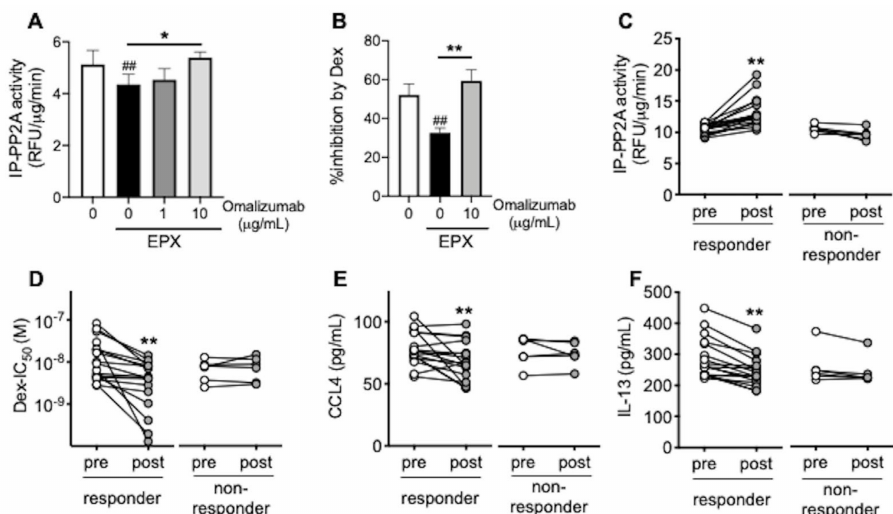
Figure 3. Effects of omalizumab on PP2A activity and corticosteroid sensitivity in airway epithelial cells. ( A , B ) BEAS-2B cells co-incubated with recombinant eosinophil peroxidase (EPX, 10 µ g/mL) for 72 h were treated with omalizumab (1 or 10 µ g/mL) for 20 min. ( C – E ) BEAS-2B cells were incubated with 1:10-diluted serum from each patient (pre- and post-treatment with omalizumab) for 48 h. Phosphatase activity in immunoprecipitates with PP2A (IP-PP2A) ( A , C ), % inhibition by dexamethasone (Dex) on TNF α -induced CXCL8 production ( B ), and IC 50 values for dexamethasone (Dex-IC 50 ) ( D ) on TNF α -induced CXCL8 production and CCL4 and IL-13 levels in supernatants ( E , F ) were evaluated. ( A , B ) Values represent the means ± SEM values of four experiments; ## p < 0.01 (vs. non-treatment control), * p < 0.05, ** p < 0.01 (as shown between the two groups). ( C – F ) Individual values in the responder group ( n = 19) and the non-responder group ( n = 6) are shown; ** p < 0.01 (vs. pre-treatment).